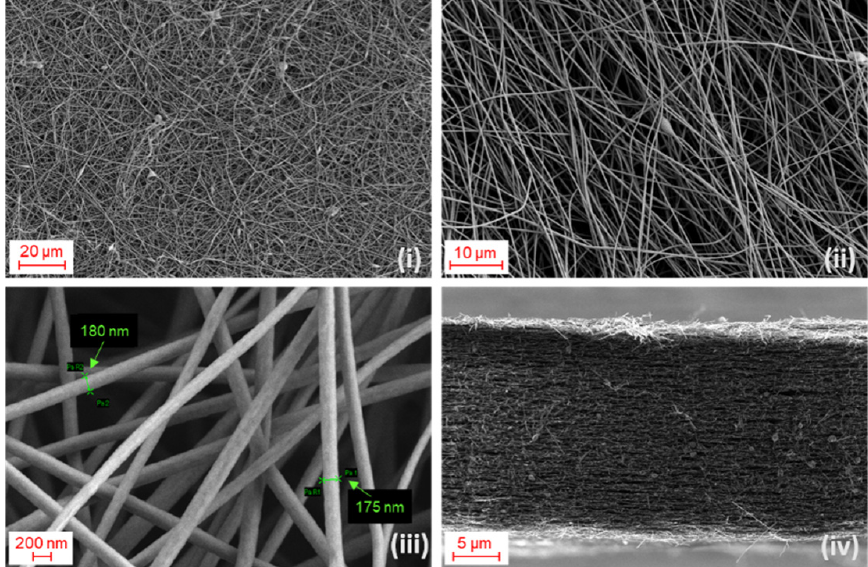
Figure 2. SEM images of ( i , ii ) as-spun carbon nanofibers at different magnifications; ( iii ) carbonized fibers with analysis of diameter; ( iv ) cross section of the mat.